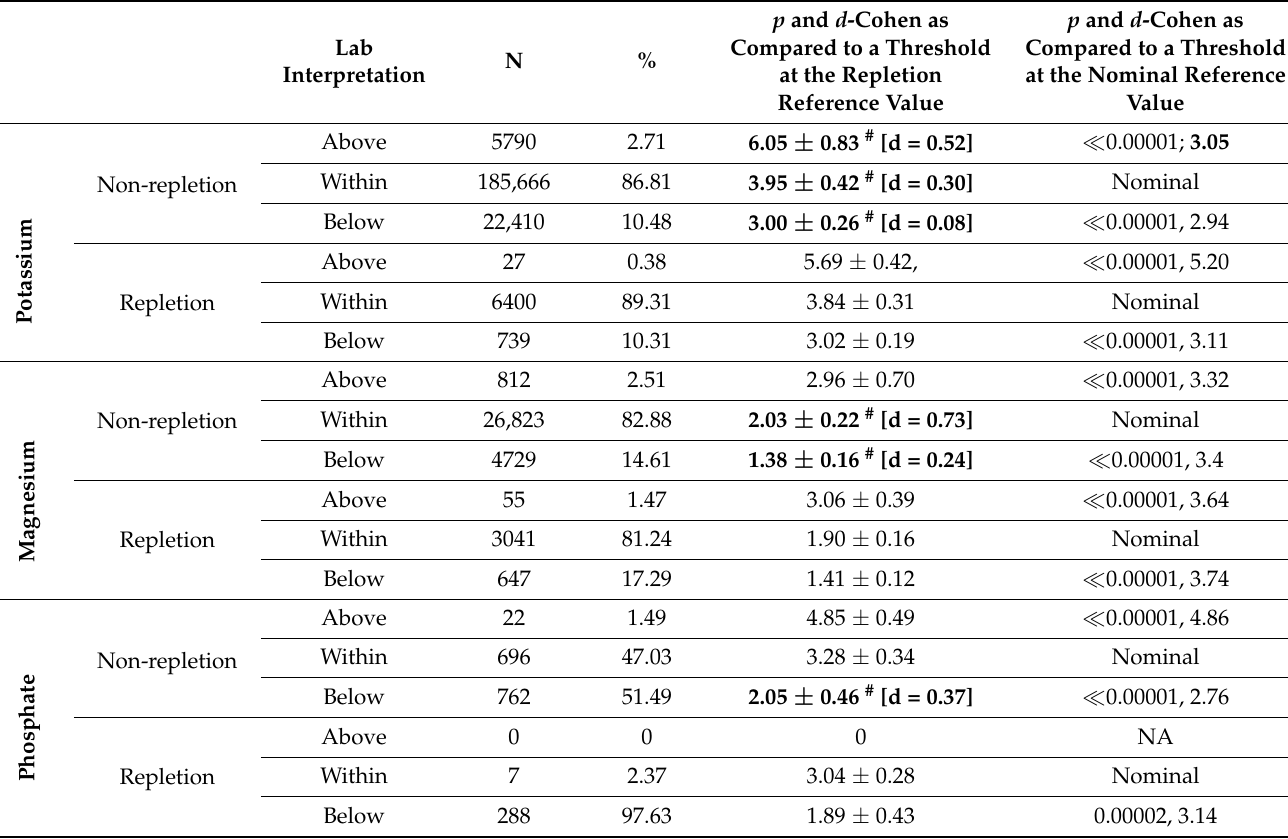
Table 1. Comparison pre-order lab values for all three major electrolytes during the three clinical scenarios.